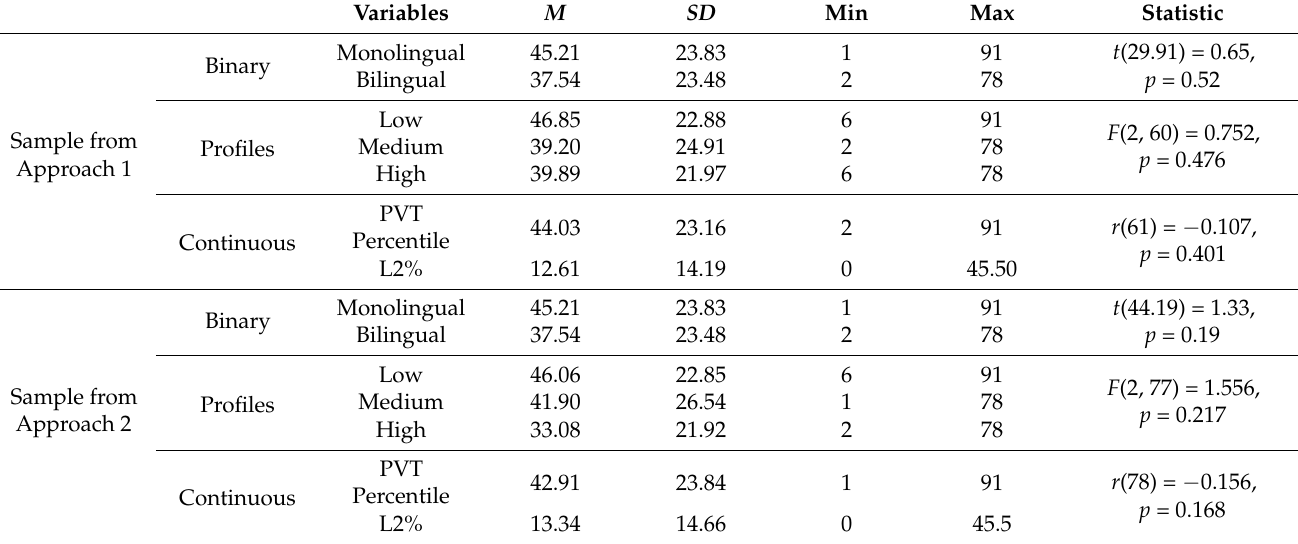
Table 2. PVT Percentile Score Analyses for All Analytical